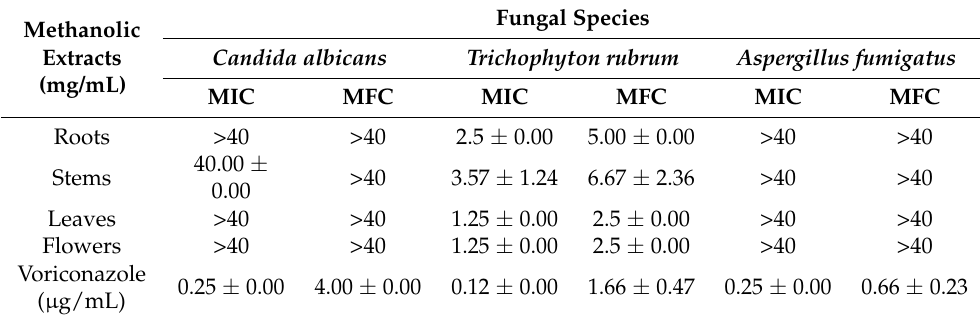
Table 11. MIC and MFC values of methanolic extracts of Cladanthus mixtus and a reference antifun- gal